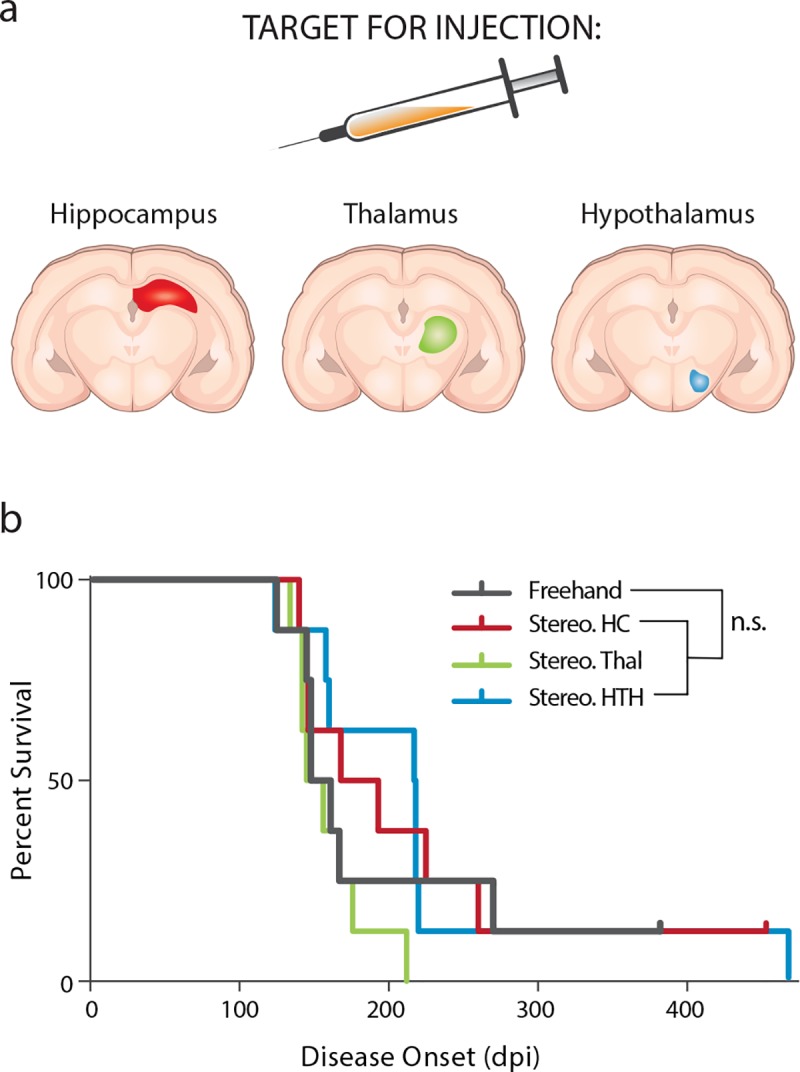
Stereotactic inoculation in TgM83+/- mice does not alter disease onset.Secondary passage of an MSA patient sample (3 μL of a 5% homogenate) was used to inoculate TgM83+/- mice either with a standard freehand injection (black) or by stereotactic inoculation into the hippocampus (Stereo. HC; red), thalamus (Stereo. Thal; green), or hypothalamus (Stereo. HTH; blue). (a) Schematic showing the experimental design. (b) Incubation times in TgM83+/- mice were consistent across all four inoculation groups.